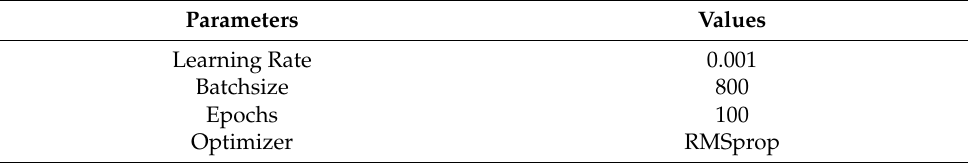
Table 5. The hyper-parameters of the proposed